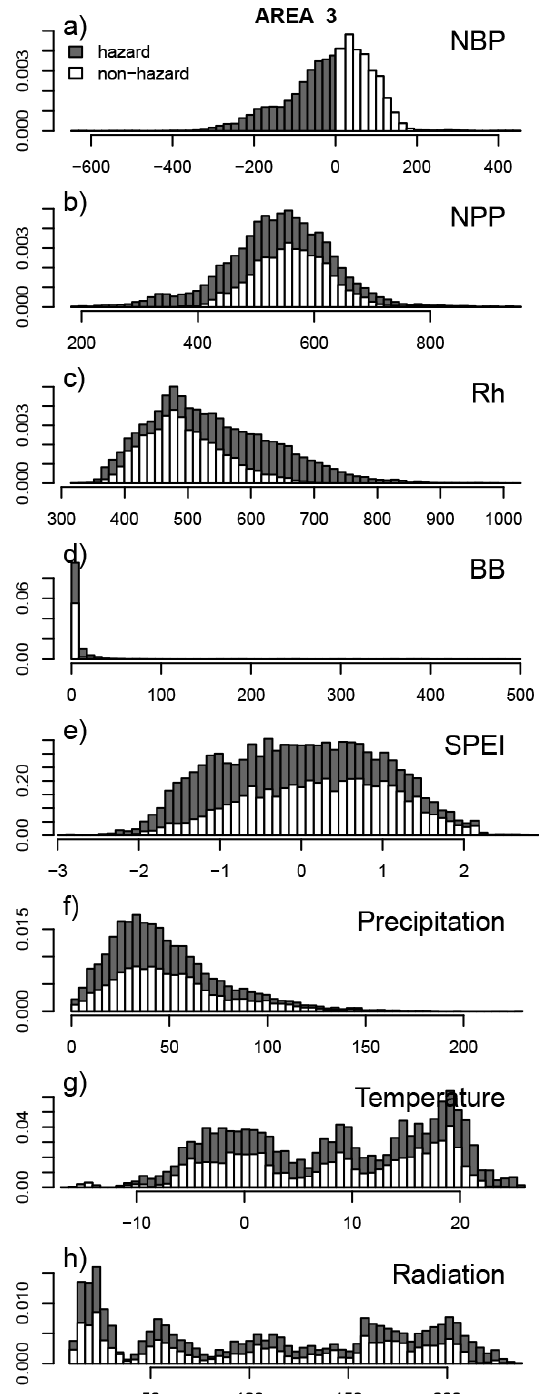
Figure B4. Probability distributions for area 3 (see Fig. B1) of (a) NBP and its contributions (b) NPP, (c) Rh, and (d) BB (all in gCm − 2 a − 1 ) as well as monthly values for (e) SPEI (dimen- sionless), (f) precipitation (mmmonth − 1 ), (g) temperature ( ◦ C) and (h) short-wave downward radiation (Wm − 2 ). Dark shading denotes values in the hazard group, white shading in the non-hazard group.